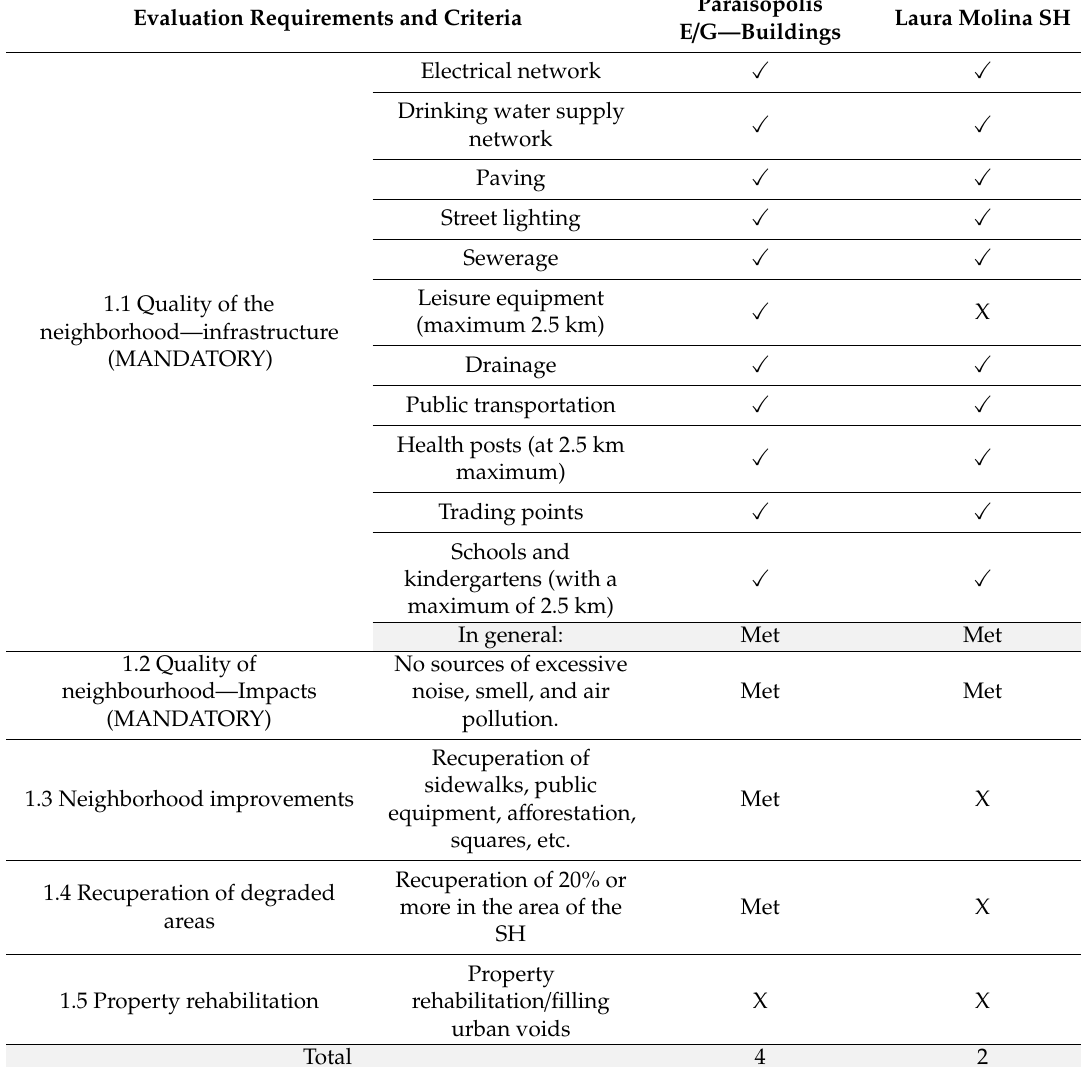
Table 5. Urban quality category—the evaluation of Parais ó polis E and G × Laura Molina social housing